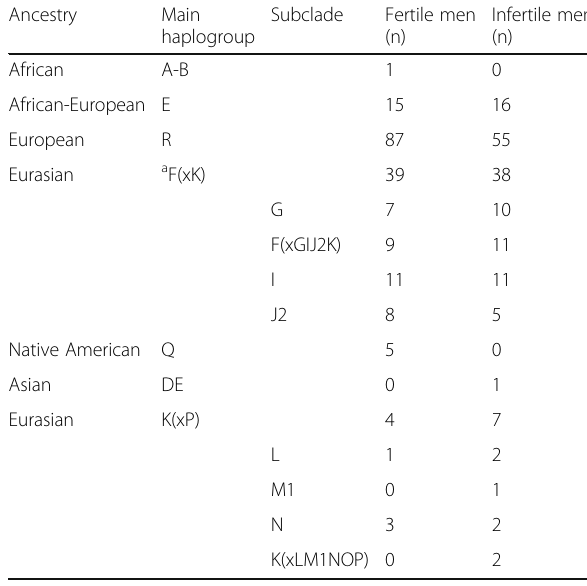
Table 1 Distribution of Y chromosome haplogroups in fertile and infertile men from Uruguay